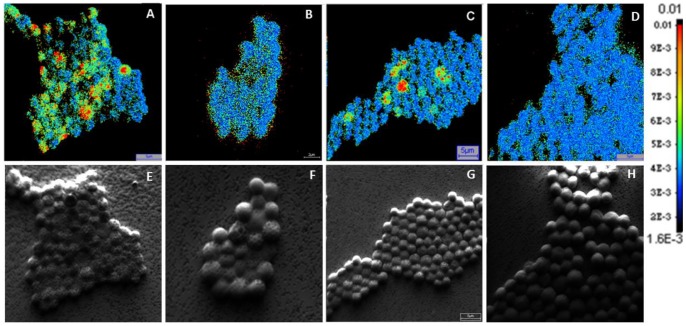
Enrichment in 15N (color scale: 15N/14N) due to N2 fixation by individual C.
watsonii cells.A. Regular dark phase. B. Regular light phase. C. Subjective dark phase. D. Subjective light phase. (Scale bars: 5 µm in A, C and D, 2 µm in B). E–H. Secondary electron images (complementary to A–D.) which are simultaneously recorded during the measurement and showing the individual cells. The aggregation of cells was an artifact of filtration; the C. watsonii cells are unicellular (as per microscopic observation), however, gather in trenches upon filtration due to the unevenness of the filtration devices at the micrometer scale.